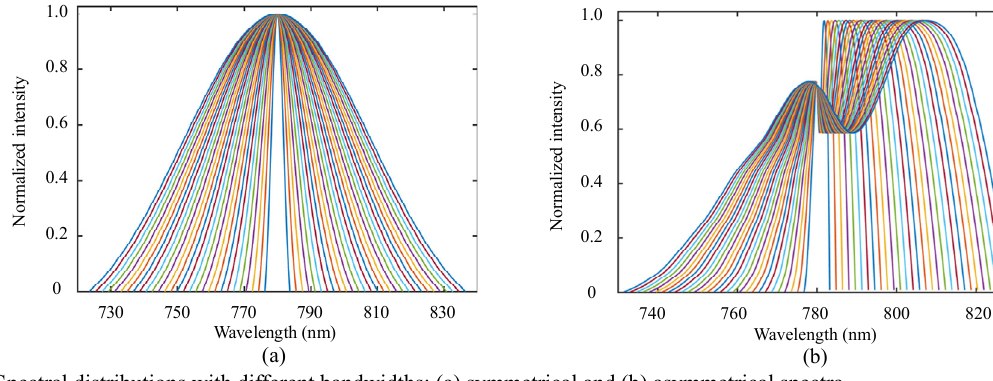
Fig. 6 Spectral distributions with different bandwidths: (a) symmetrical and (b) asymmetrical spectra.